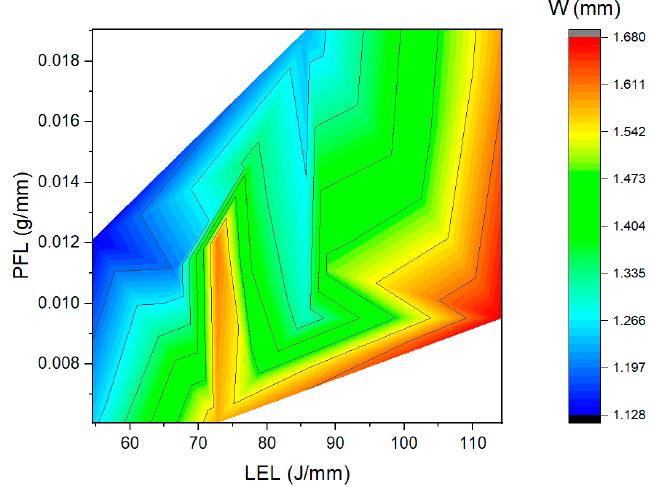
Figure 3. Effect of LEL and PFL on W .